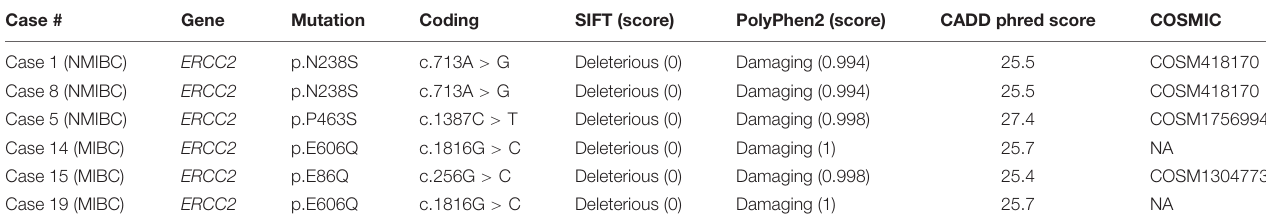
FIGURE 2 | ERCC2 mutations sensitive to platinum-based therapy. (A) Lollipop plots showing the mutation sites on ERCC2 . Green circles indicate missense mutations. We identified four types of mutation (p.E86Q, p.N238S, p.P463S, and p.E606Q) in six patients. The amino acid is conserved at codon 606 across several species. (B) Tumor-identical mutations in urine precipitate (left panel) and supernatant (right panel) in Case #14. Variant allele fraction (VAF) was plotted before and after neoadjuvant therapy. All mutations in urine precipitation (left) and supernatant (right) were not detectable after chemotherapy. (C) Computed tomography image of lymph node metastasis in a patient (Case #14) harboring ERCC2 p.E606Q mutation. This patient was responsive to carboplatin-based chemotherapy. Yellow arrows indicate lymph node metastasis. The metastatic tumor burden was decreased after platinum-based neoadjuvant chemotherapy. TABLE 2 | Mutation impact on protein function predicted by in silico